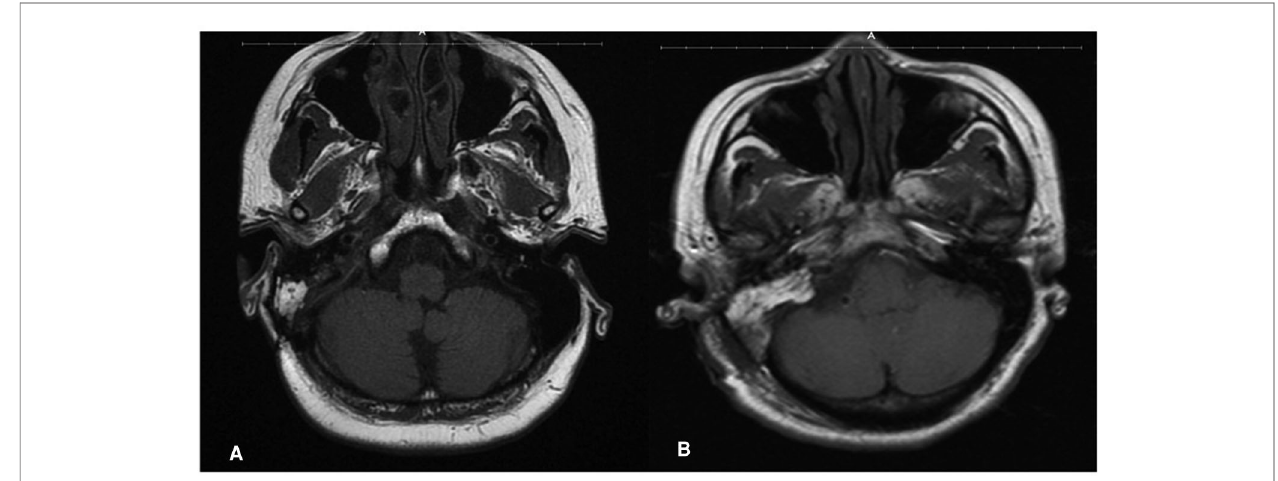
FIGURE 3 | MRI T1 showing the fat packing in the patient with no stenosis ( A ) and stenosis ( B ) in the early postoperative